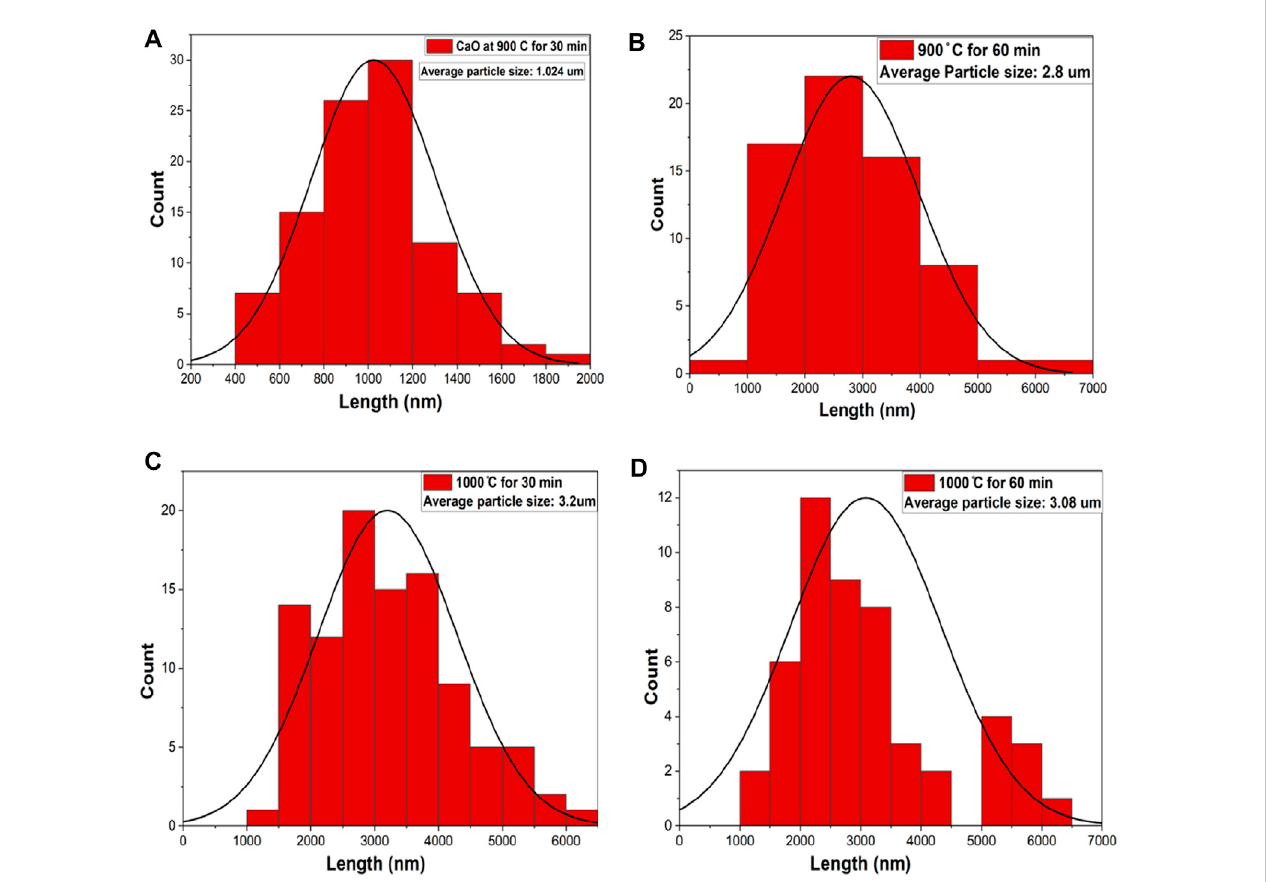
FIGURE 6 Particle sizedistributionofcalcinedCFB. (A) CFBcalcinedat900 ° Cfor 0.5h, (B) CFBcalcinedat900 ° Cfor1.0h, (C) CFBcalcined at1000 ° Cfor0.5h,and (D) CFB calcined at 1000 ° C for 1.0